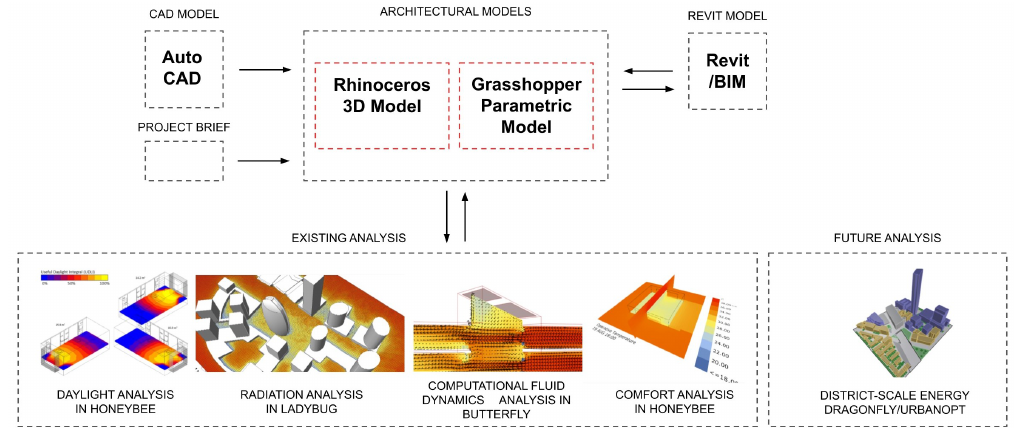
Figure 8. Rhino and Grasshopper